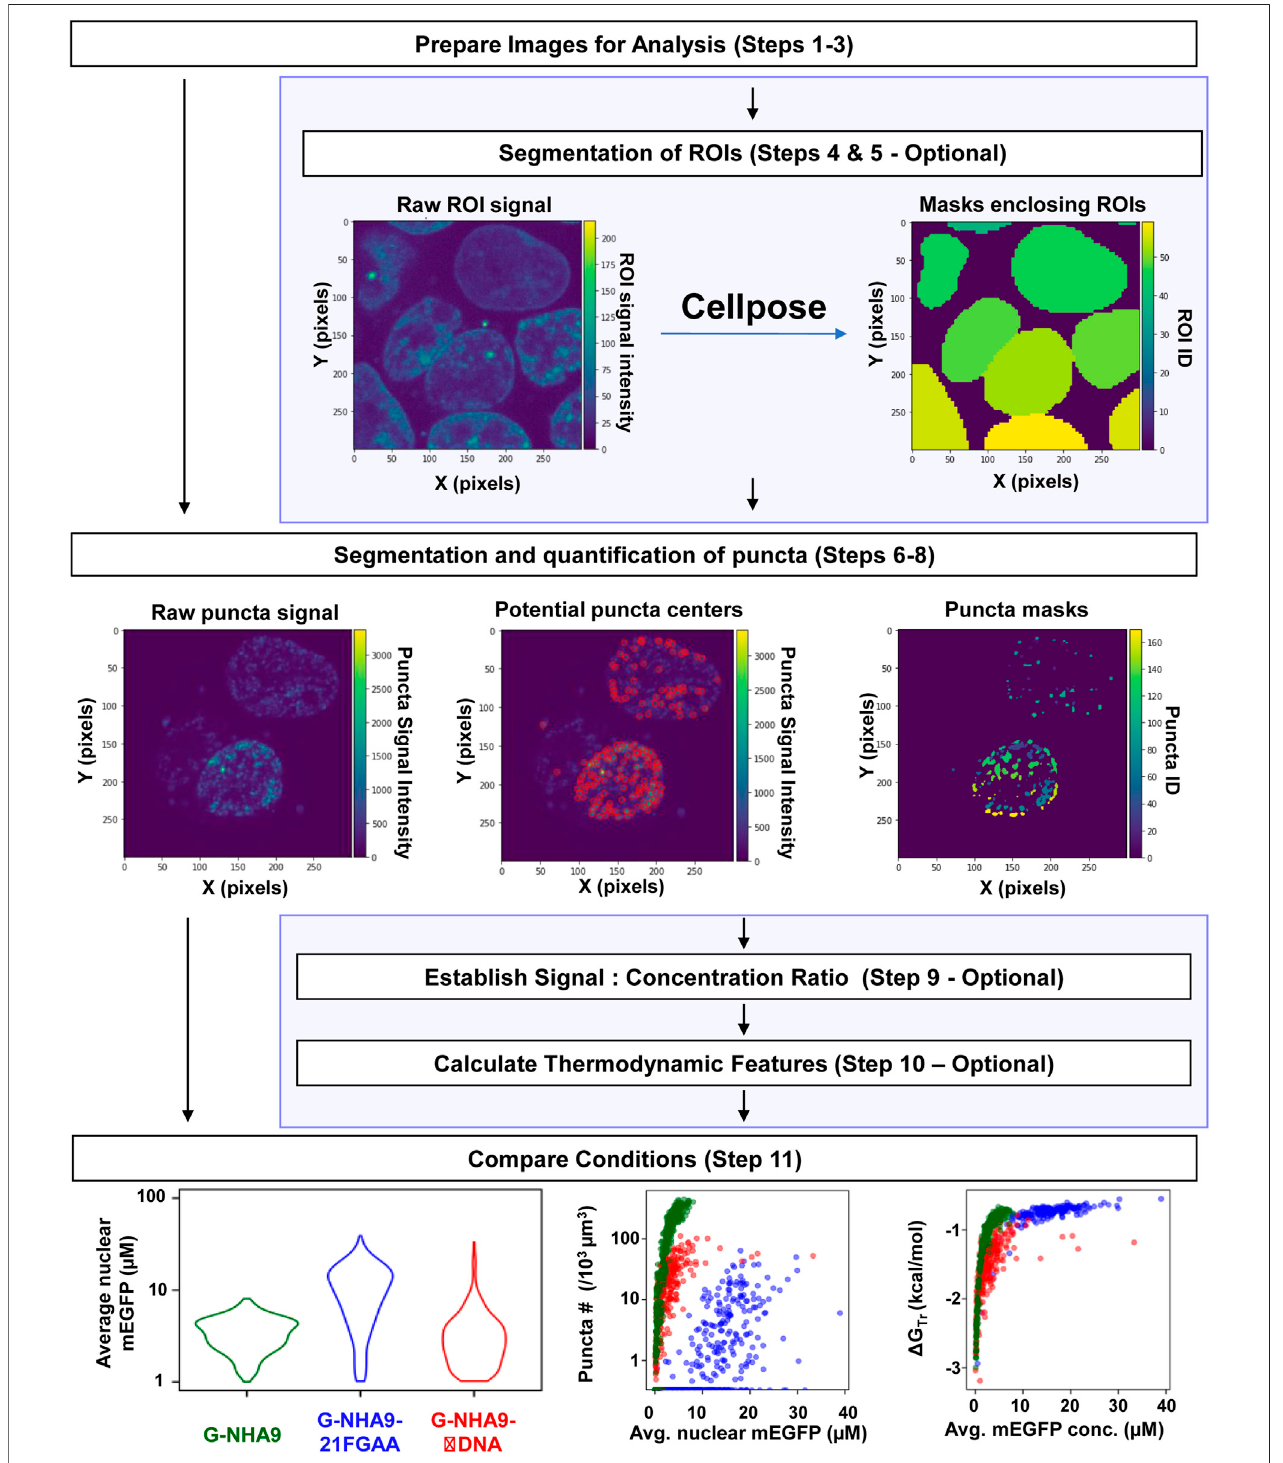
FIGURE 1 | The Punctatools image analysis pipeline. After samples are prepared and image stacks are acquired (Steps 1 – 3), users are fi rst given the option to segmentregions ofinterest (ROIs) usingCellpose (Steps 4 and5).Followingthis, puncta centers areidenti fi ed from rawpuncta signals,and puncta aresegmentedfrom thebackground(Steps6 – 8).Usersaregiventheoptiontoestablishasignaltoconcentrationratio(Step9),whichcanbeusedwhencalculatingthermodynamicfeatures (Step 10) and making statistical comparisons (Step 11). Optional steps are highlighted by light-blue background. Average mEGFP concentrations shown on the graph x -axes are estimates derived from calibration and are subject to the limitations of this calibration as noted in the main text.